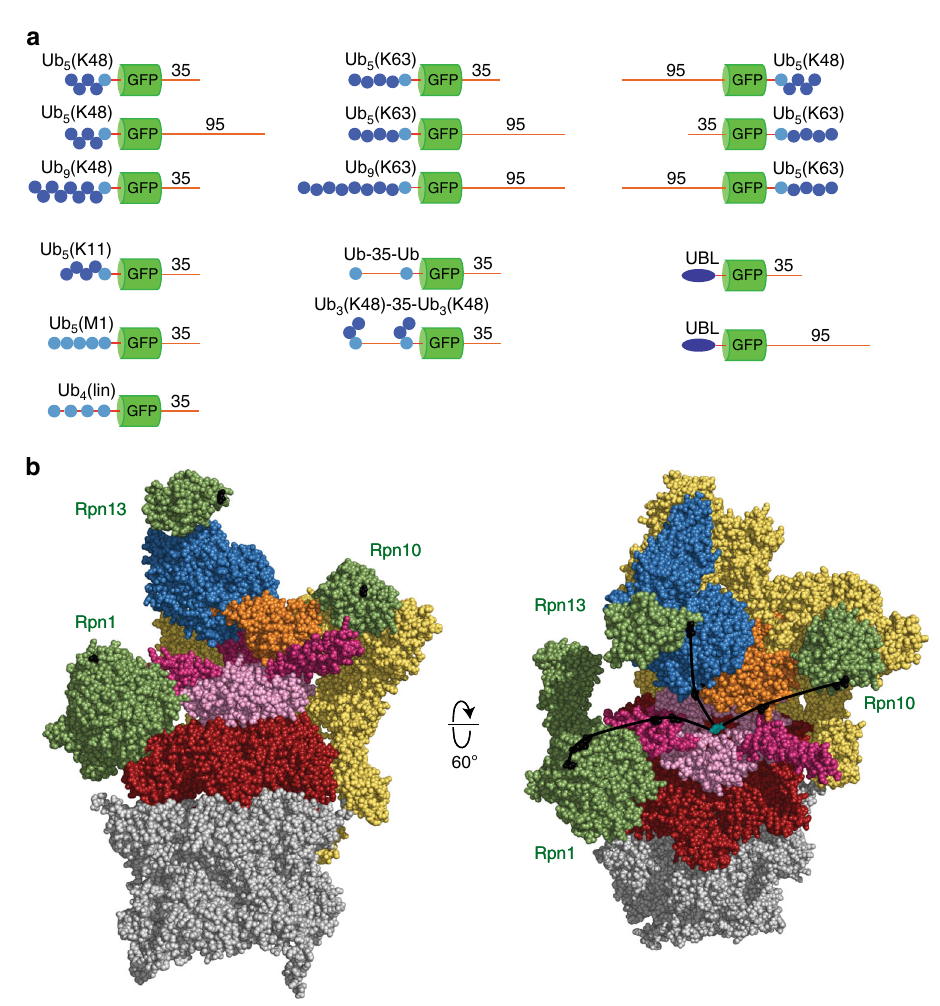
Fig. 1 Model substrates and proteasome particles. a Schematic representation of the substrate proteins analyzed. GFP shown in green, co-translated ubiquitin domains shown in light blue, enzymatically added ubiquitin moieties shown in dark blue, intrinsically unfolded regions of proteins shown as red lines. In the three-dimensional structure of GFP, the N- and C-termini are adjacent to each other so that ubiquitin chain or UBL and initiation region are next to each other in space. b Structure of the proteasome in the s1 state (PDB4CR2) in two orientations. The structure broadly includes one half of the 20S core particle (gray) and the 19S regulatory particle (multiple colors). The ATPase (Rpt) subunits are color-coded respect to domains rather than subunits, with the AAA + domains in magenta, the OB ring in pink, and the coiled-coil domains in purple. The position of the pore-1 loop is indicated by a red circle in the right panel. The Ub/UBL receptors Rpn1, Rpn10, and Rpn13 are shown in green, and Rpn2 is shown in light blue. The DUB Rpn11 is shown in yellow, and the remaining components of the lid are shown in light yellow. Black lines indicate a direct path along the surface of the proteasome from the Ub/UBL-binding sites in Rpn1 and Rpn13 to the pore-1 loop at the top of the ATPase ring. The Ub/UBL-binding UIM domain of Rpn10 is not visualized in this structure; instead, the black line indicates the path from the last resolved residue of the VWA domain of Rpn10 to pore-1 loop. The distances are approximately 107 Å for Rpn13, 100 Å for Rpn1, and 95 Å for Rpn10. The UIM domain of Rpn10 is attached to the VWA domain by an unstructured linker of approximately 20 amino acids, which may reduce the distance from the ubiquitin-binding site to the pore-1 loop by 20 – 30